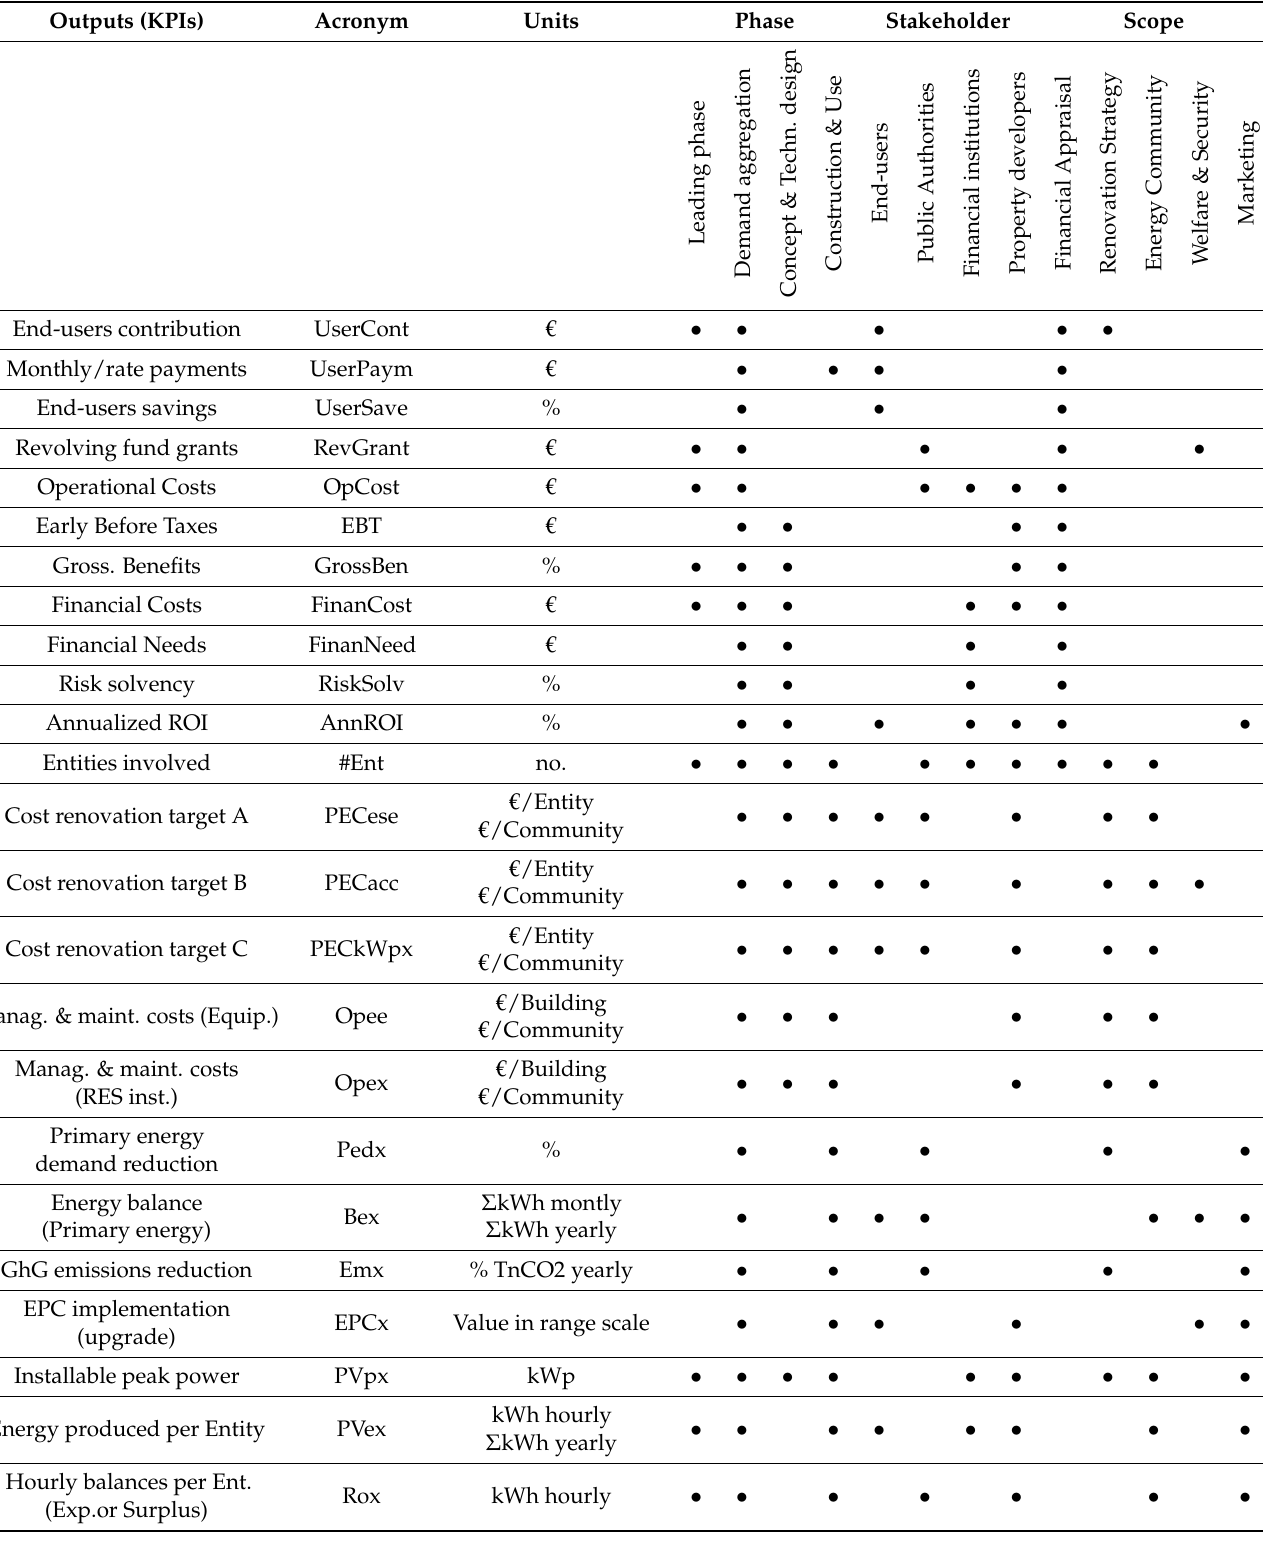
Table 3. List of output (KPIs) of the PEDRERA model according to the “scopes” and stakeholder engagement for each phase of the process. Source: